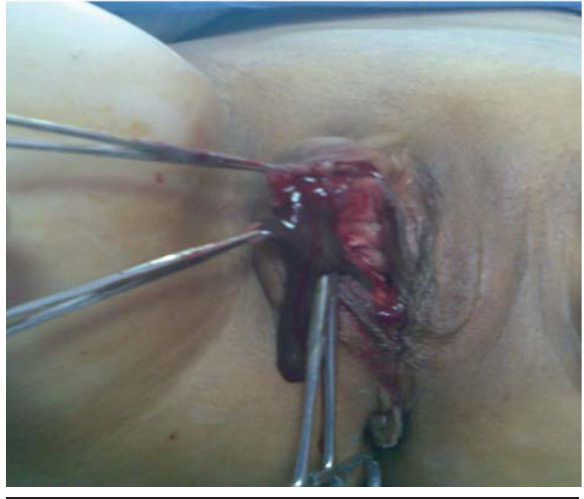
Figure 1. During surgery, the cyst ruptured and a chocolate-colored liquid escaped onto the surgical (cid:2) eld. Histopathological (cid:2) ndings showed endometrial stroma with hemorrhage. The hemorrhagic areas showed clusters of hemosiderin- laden macrophages (Figure 2).